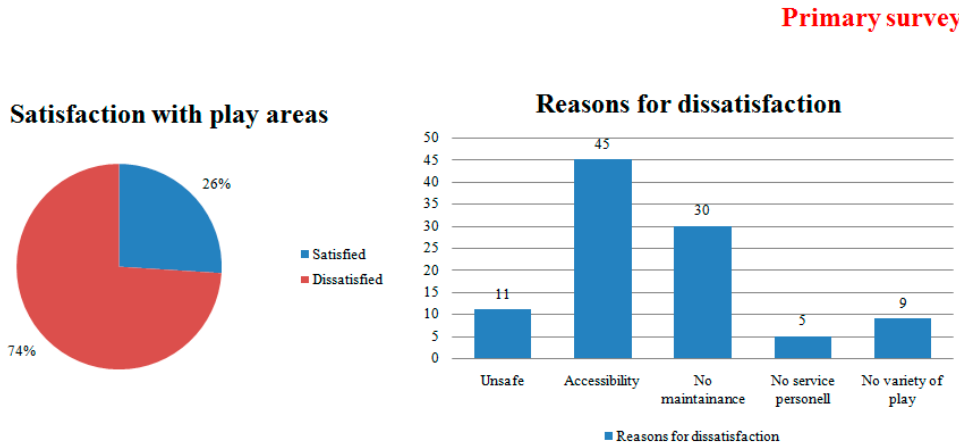
Figure 6. Children’s opinion on the existing play provisions in their neighborhoods.